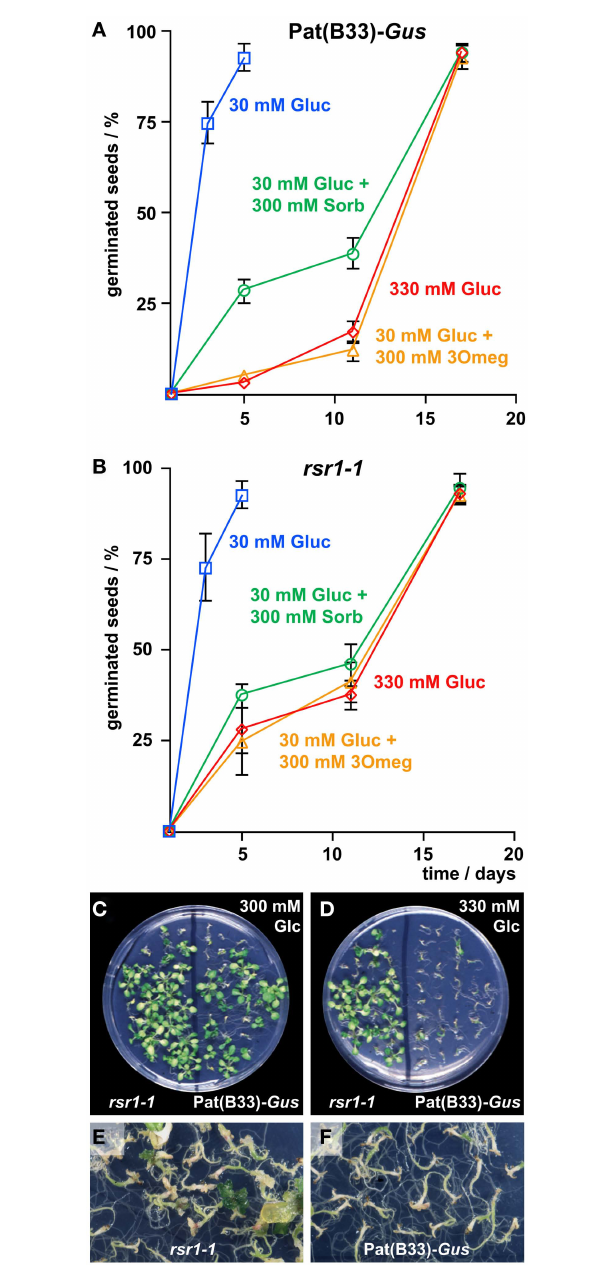
FIGURE 3 | Sugar insensitivity of germination and establishment in rsr1-1 . (A,B) Germination rates of rsr1-1 and Pat(B33)- Gus seeds on MS-medium supplemented with different concentrations of Glc, 3Omeg, or sorbitol. Only on 330mM Glc and on 30mM Glc + 300mM 3Omeg significant differences were observed between rsr1-1 and Pat(B33)- Gus . Values represent the mean ± SD of three replica of 70 seeds each. (C) On plates containing 300mM Glc both rsr1-1 and Pat(B33)- Gus were able to initiate chlorophyll synthesis and the formation of true leaves. (D) 330mM D-Glc inhibited establishment of autotrophic growth of Pat(B33)- Gus whereas rsr1-1 could still develop normally. (E) After 2months on MS-medium supplemented with 360mM D-Glc, rsr1-1 developed callus-like enlargements of the apical meristem, which were not observed in Pat(B33)- Gus (F) .